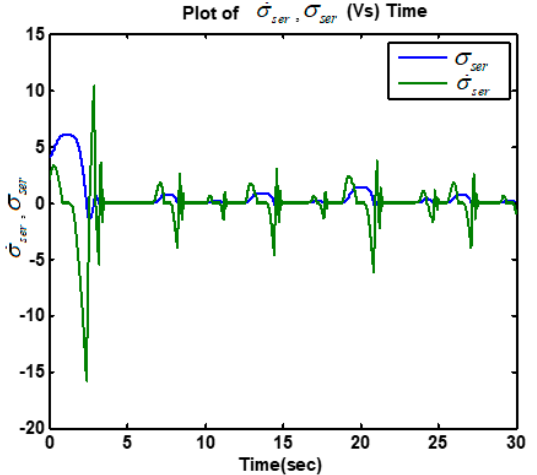
Figure 13. Plot of the servomotor sliding variable σ ser ,